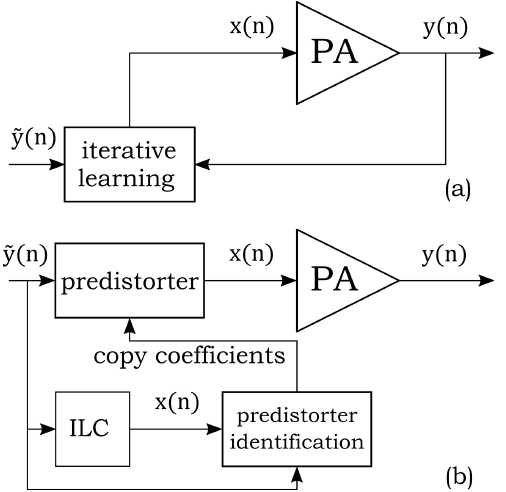
Figure 2. Block diagrams for DPD by Iterative Learning Control (ILC). ( a ) Identification of the pre- distorted signal (non-parametric) through iterative optimization; ( b ) DPD coefficients identification (parametric) using the optimum predistorted